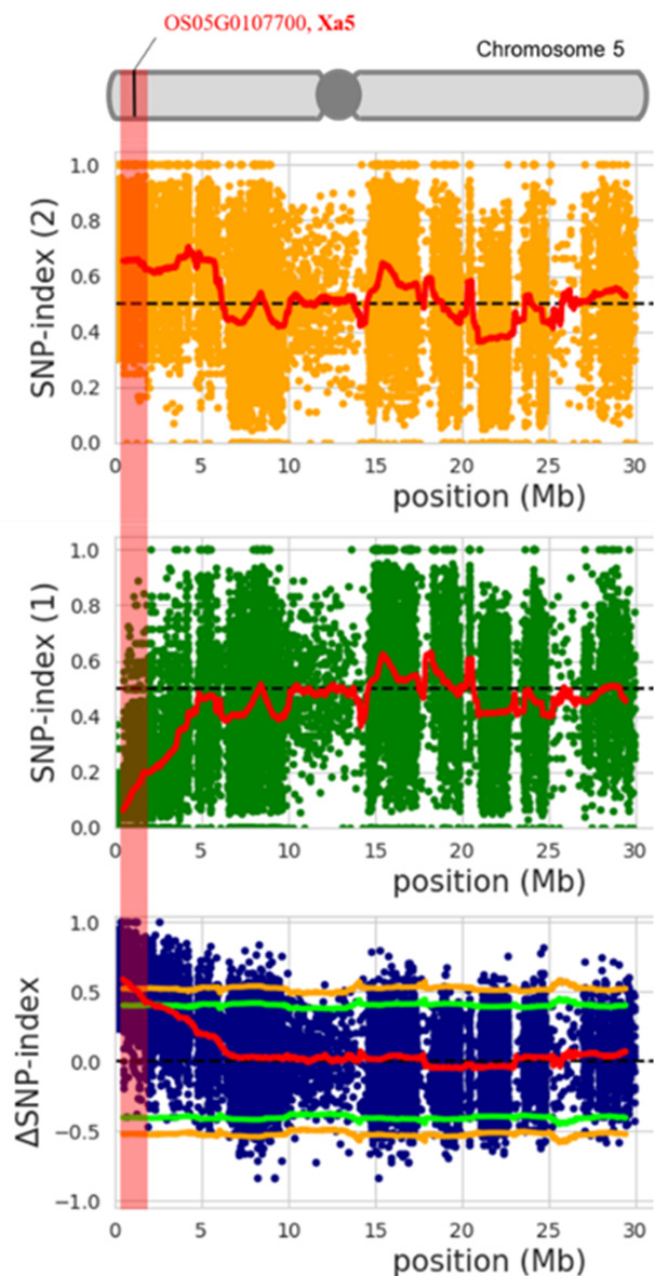
Figure 3. SNP index plots between the S-bulk (top; orange dots) and R-bulk (middle; green dots), and plots of the ∆ (SNP index) (blue dots) on chromosome 5 showing the genomic region with different SNP indices in two bulks. The identified region encompassing xa5 is highlighted. Table 3. Summary of the genomic region associated with resistance to bacterial leaf streak.